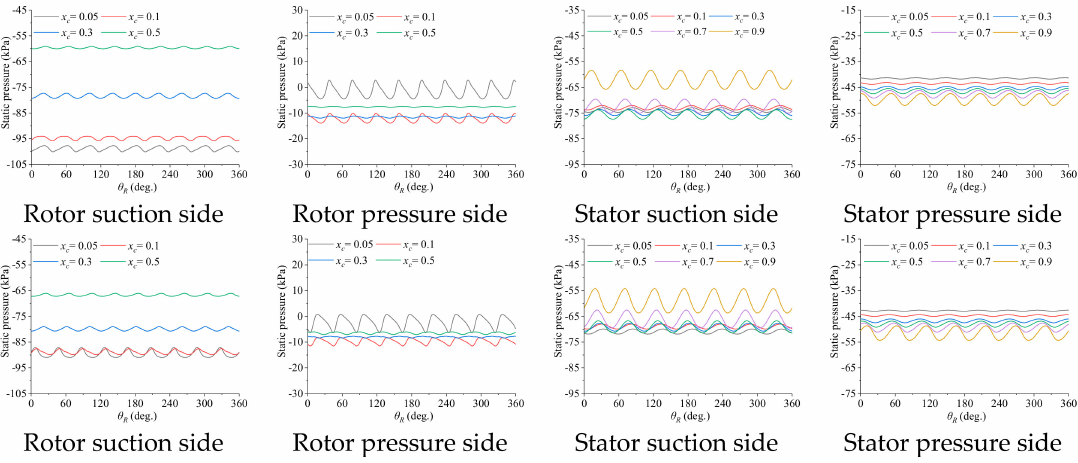
Figure 17. Blade-surface pressure oscillations in a complete revolution of the rotor at 0.7 R tip ( top row ) and 0.95 R tip ( bottom row ). x c denotes the chordwise location from section nose in fractions of the chord length. θ R denotes the angular position of a rotor blade. Q = 0.42 m 3 /s.